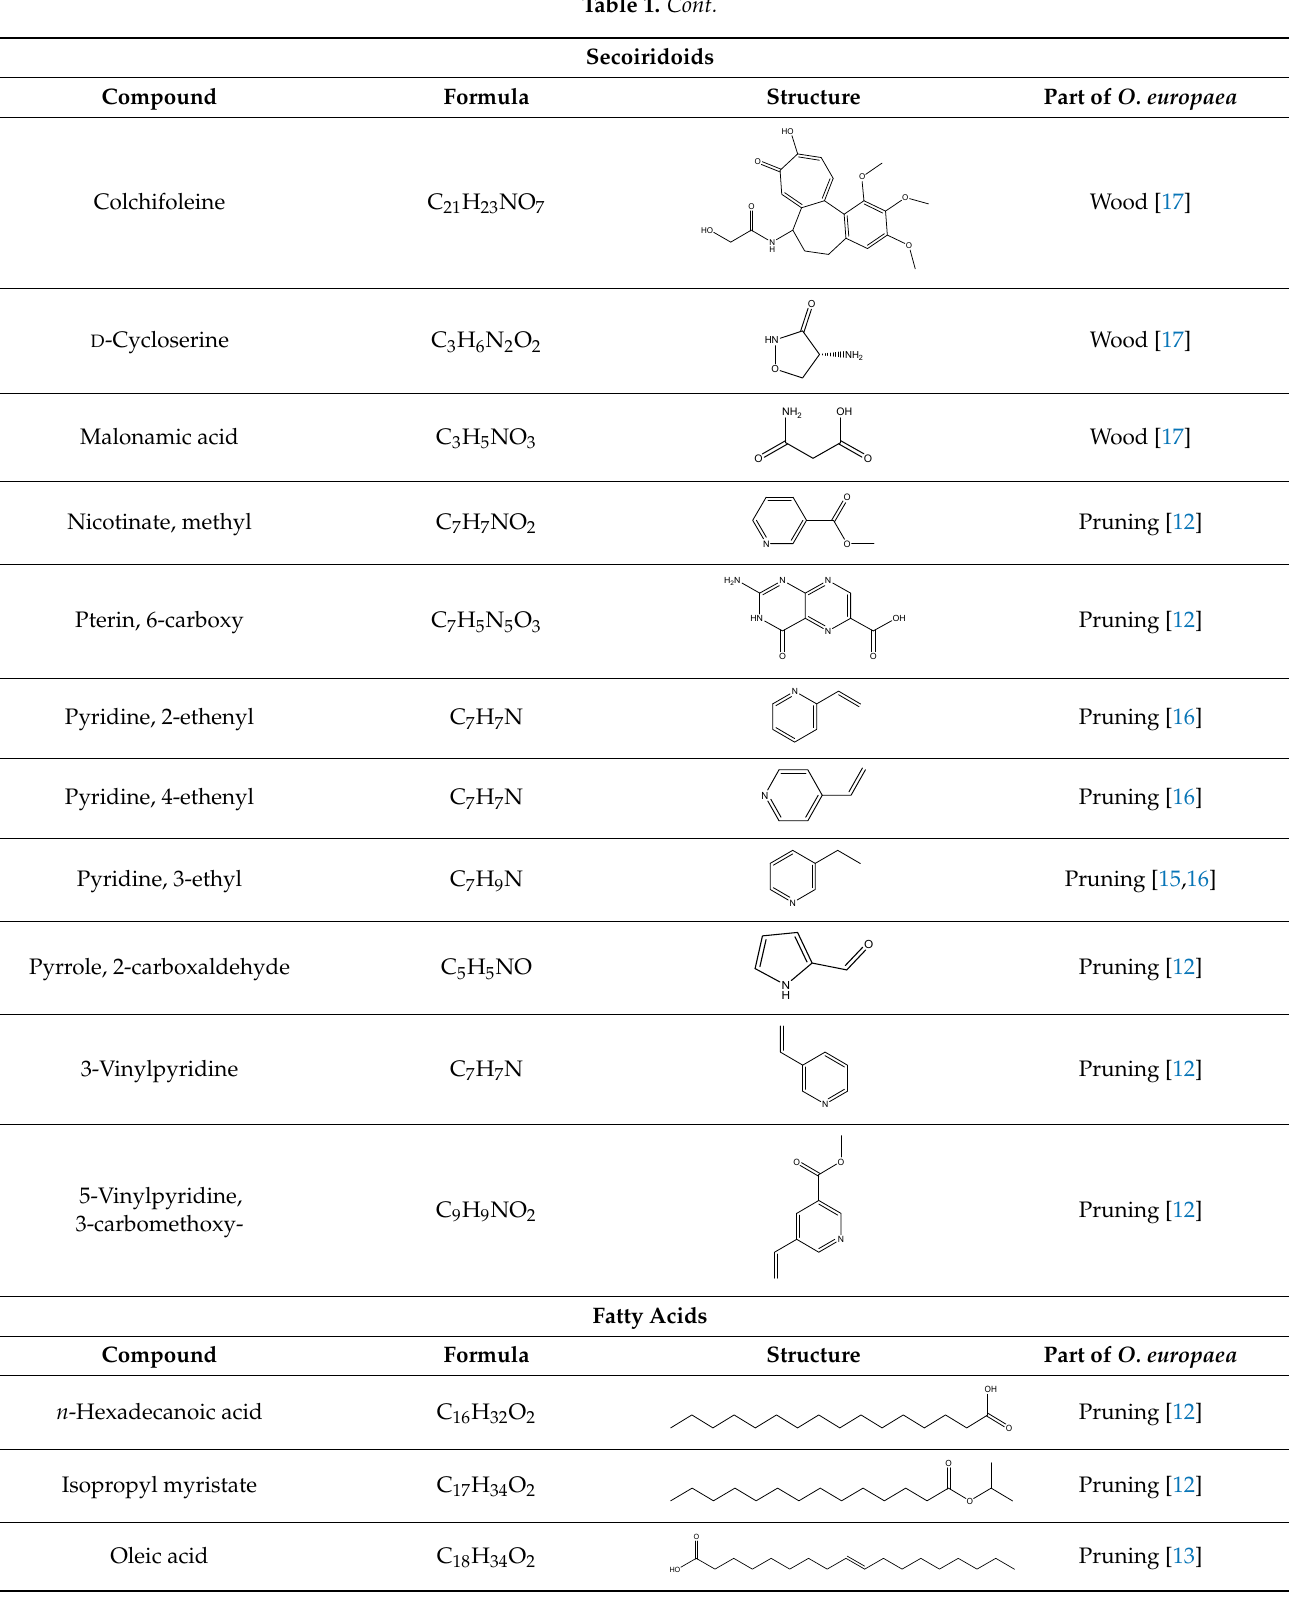
Table 1. Cont. Secoiridoids Formula Structure Part of O.